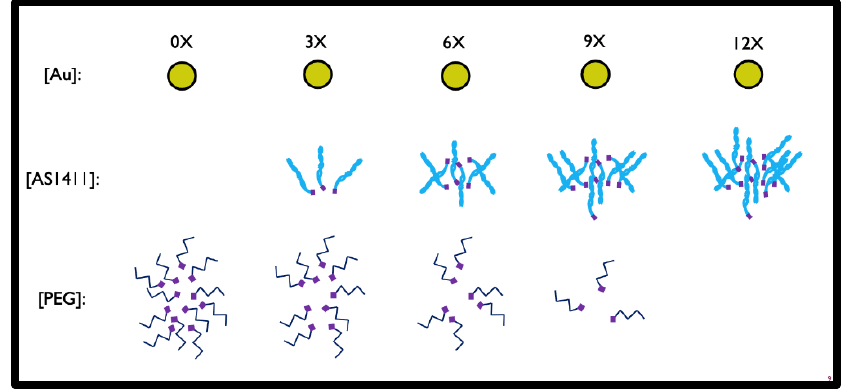
Figure 2. Visual description of GNP ratios tested.